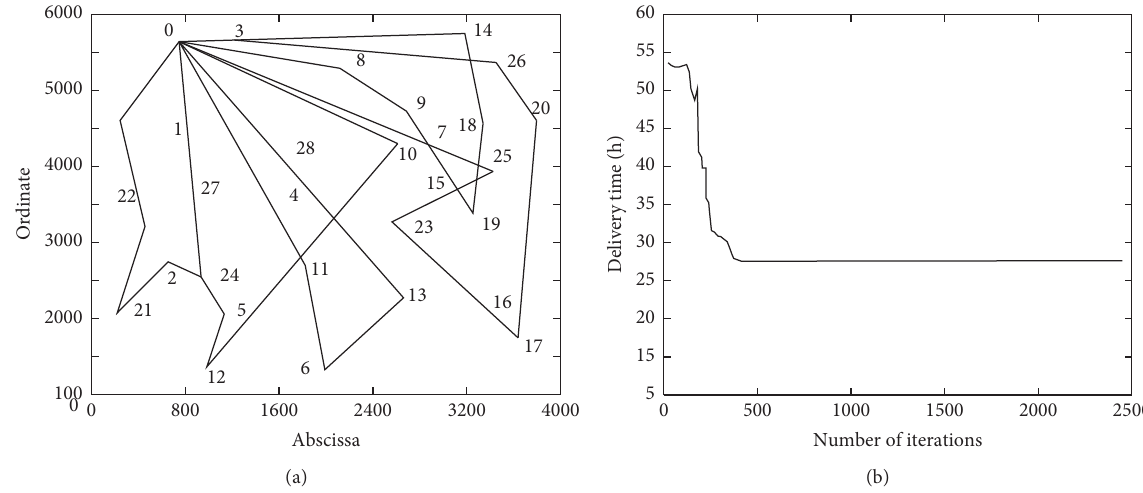
Figure 7: Operation results of the proposed model. (a) Optimization path. (b) Minimum cost of optimized path.